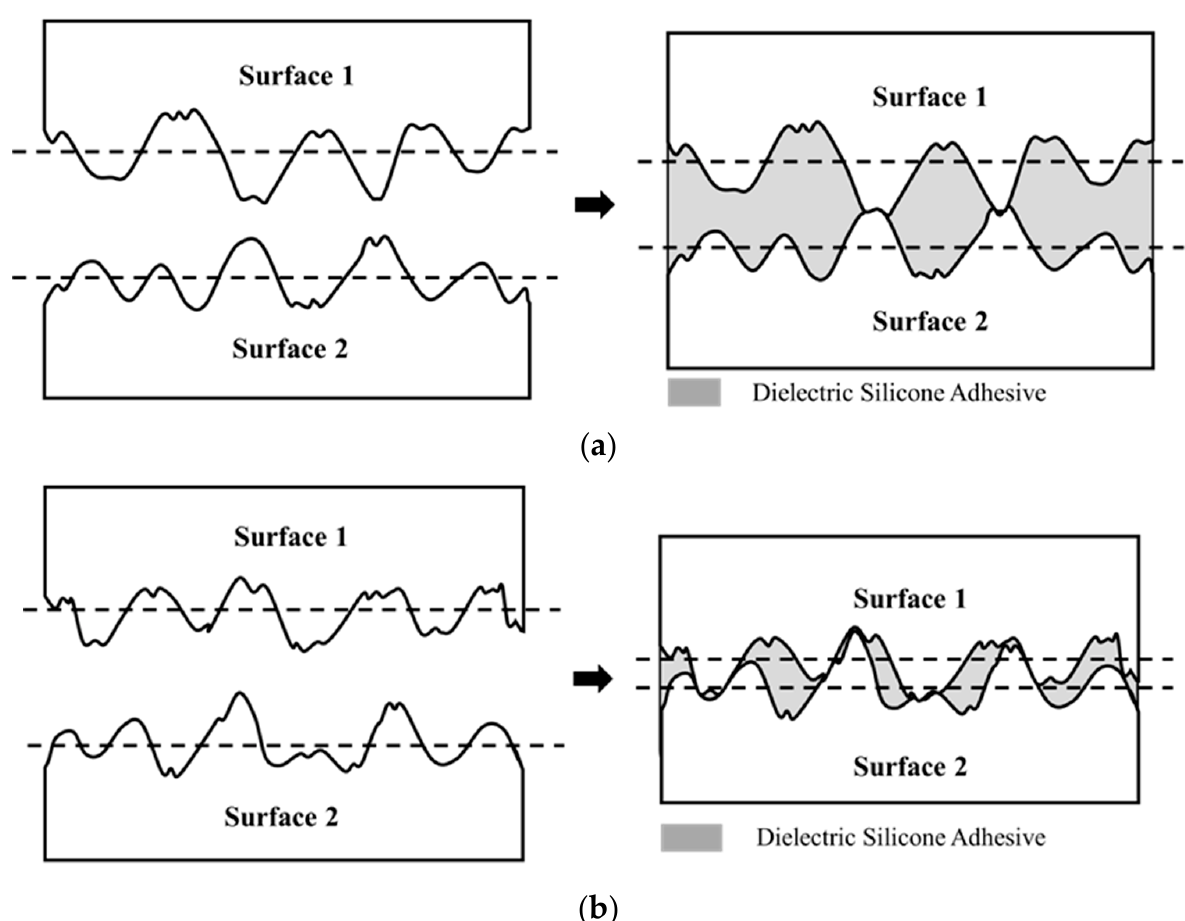
Figure 2. Schematic illustration of the BLT limits: ( a ) the maximum BLT and ( b ) the minimum BLT. The maximum BLT is achieved when the two highest ridges on two surfaces are contact with each other, and the minimum BLT is reached when the highest ridge on surface 2 is contact with the deepest valley on surface 1.